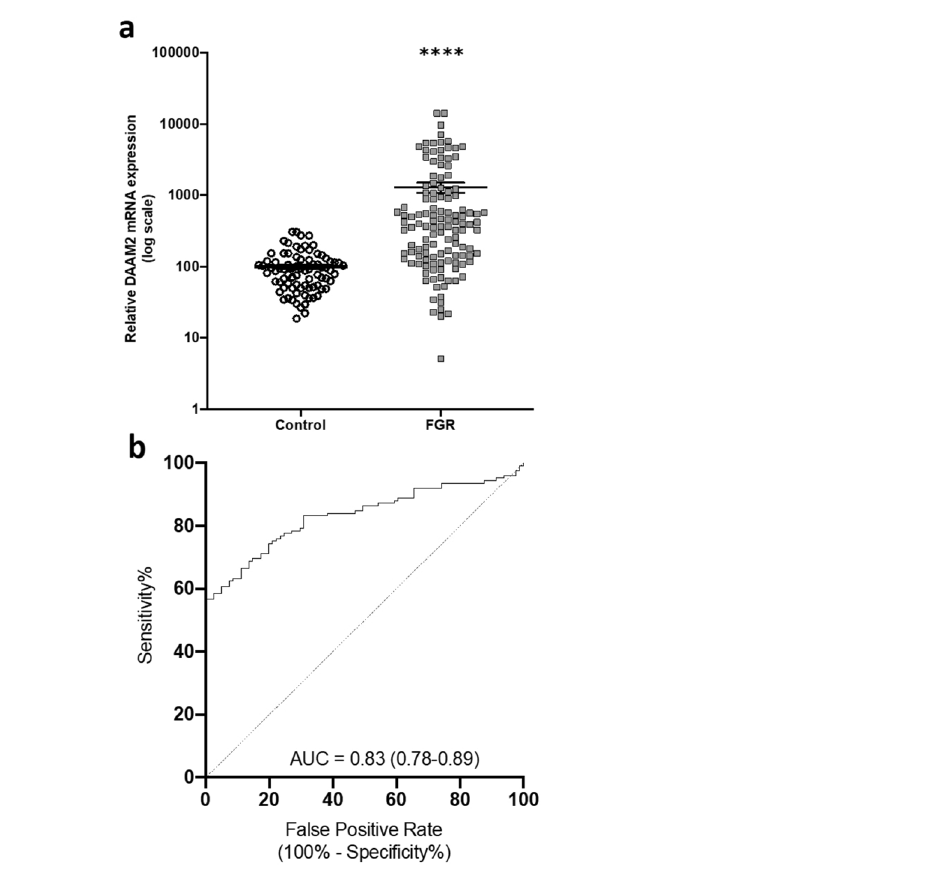
Figure 1. Expression of DAAM2 mRNA in the maternal circulation from pregnancies complicated by preterm fetal growth restriction (FOX Study). DAAM2 mRNA data is expressed as log expression; error bars are median ± IQR. AUC = 0.83; 95% Confidence Interval (0.78–0.89). ****p <